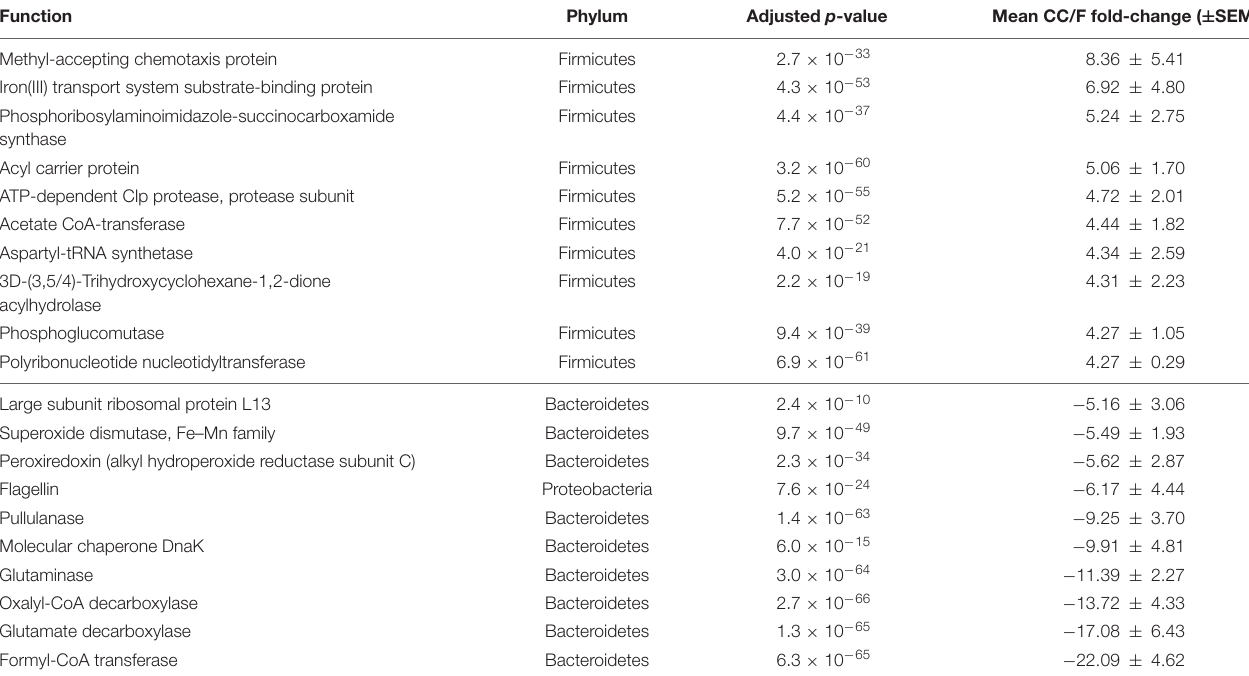
TABLE 1 | Functional-taxonomic features with significantly differential abundance between cecal and fecal metaproteome.